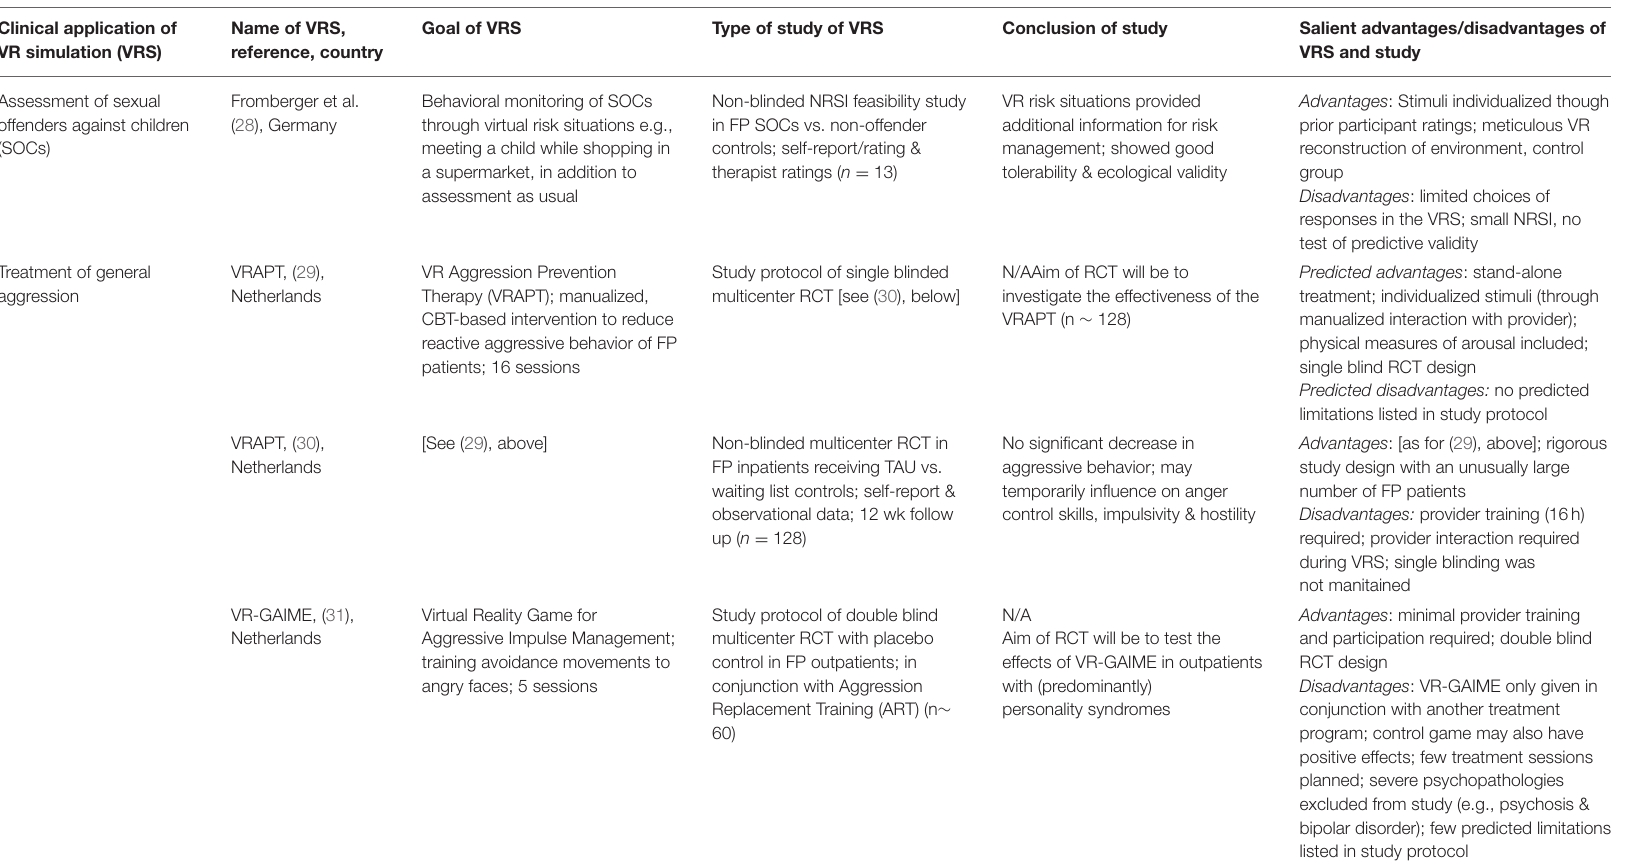
TABLE 1 | VR and forensic